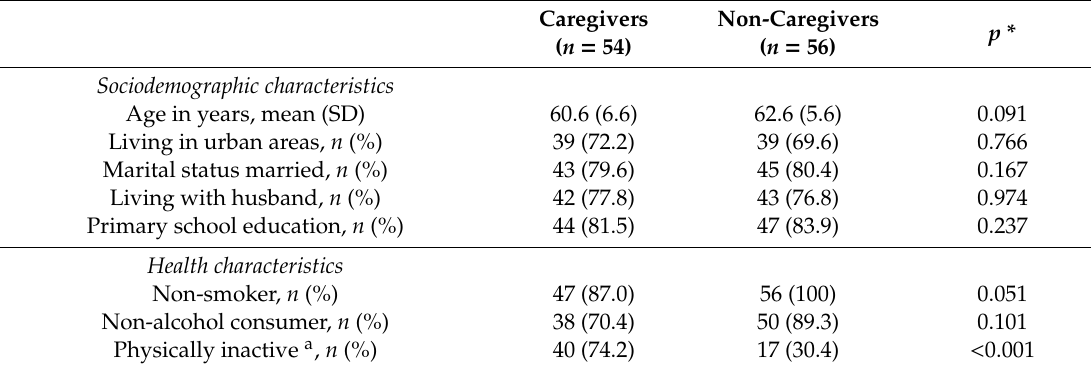
Table 1. Sociodemographic, health, and caregiving characteristics of